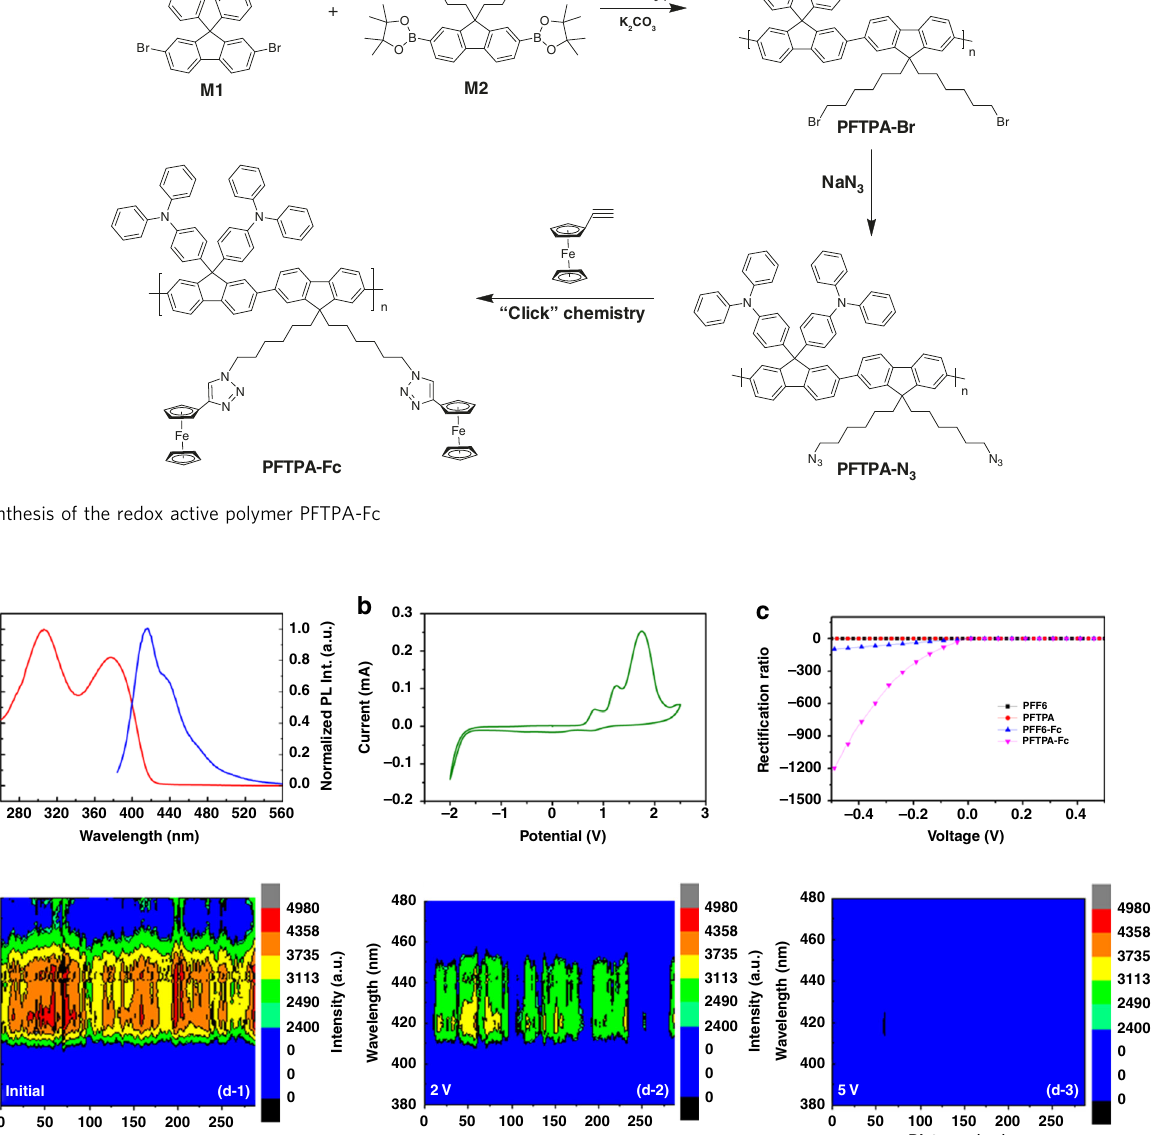
Fig. 2 Spectroscopic and electrical characteristics of PFTPA-Fc. a UV-Visible absorption (red) and fl uorescence (blue) spectra and b cyclic voltammetry plot of PFTPA-Fc. c Current – voltage of the ITO/polymer/Pt sandwich structures device constructing from different polymers of PFF6, PFTPA, PFF6-Fc, and PFTPA-Fc, respectively. d Fluorescence line scan image of the ITO/PFTPA-Fc/Pt device at different oxidation state, each composed of 122 spectra acquired along a 287 μ m straight line